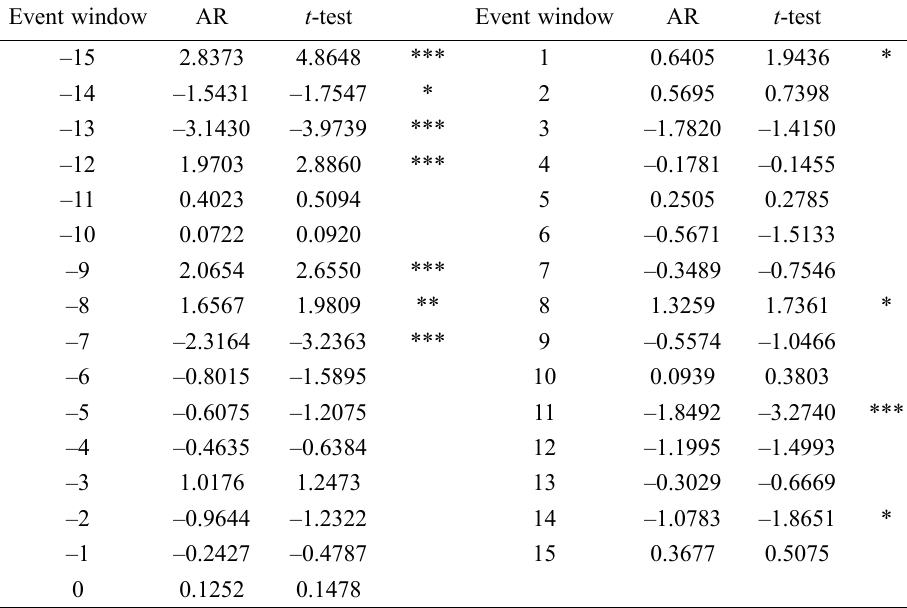
Table 7. Average AR of other medical–related during the period of infectious diseases Event